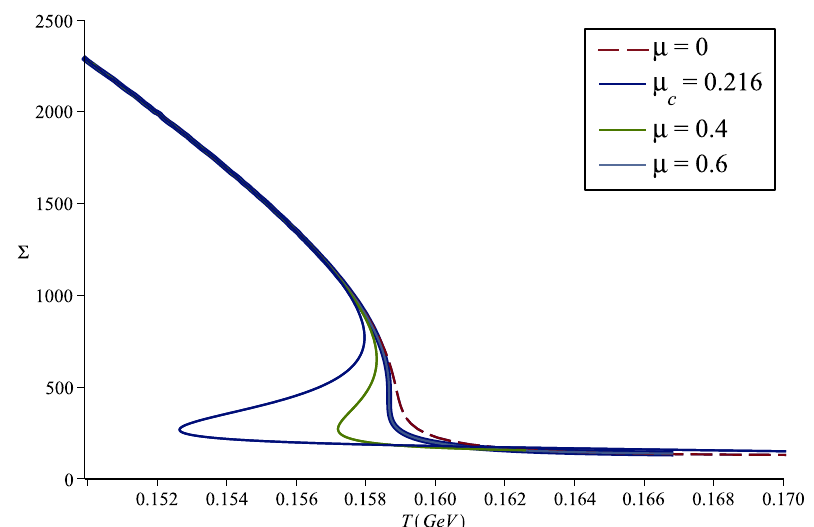
Figure 6 . Quark condensation vs. temperature at different chemical potentials. At low tempera- ture, the non-zero condensation implies the chiral symmetry breaking. While at high temperature, the condensation approaches to almost zero that implies the chiral symmetry restore. For µ < µ c , the quark condensation is a monotonous function of temperature, which becomes multi-valued for µ > µ c